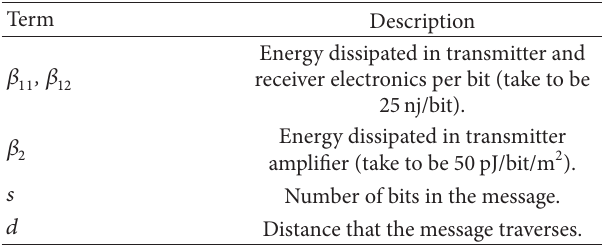
Table 2: Parameters for the communication energy